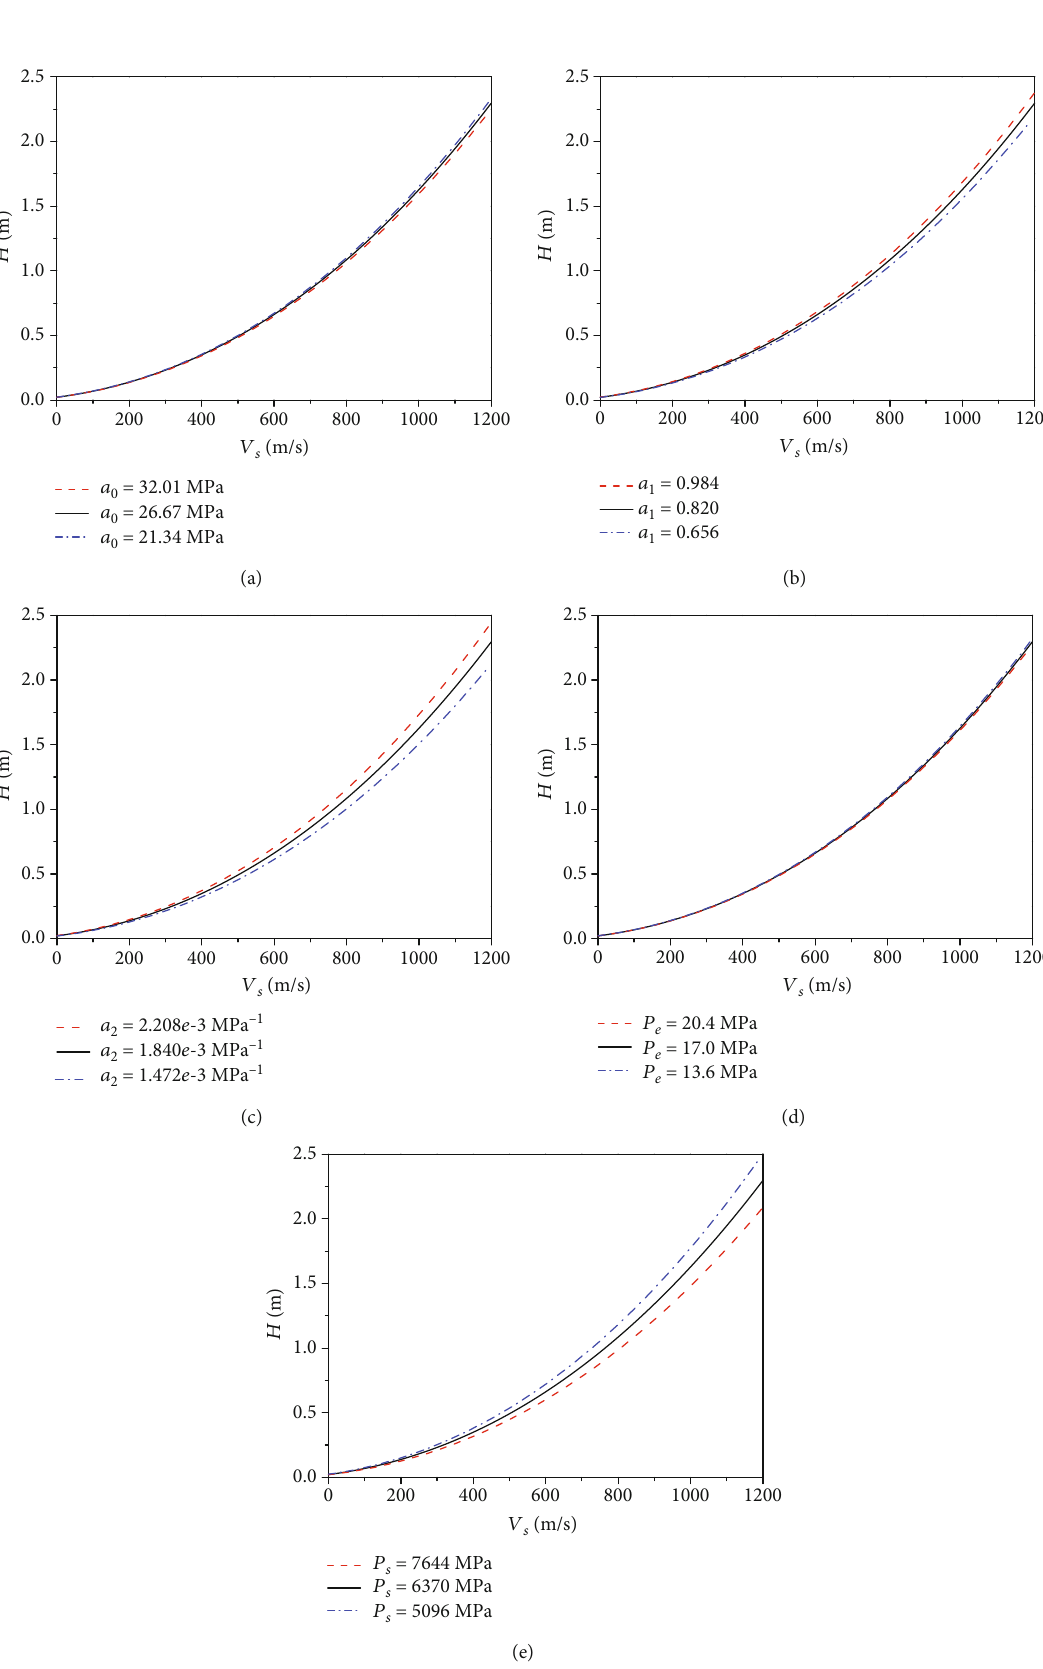
0 , (b) a 1 , (c) a 2 , (d) P e , and (e) P s